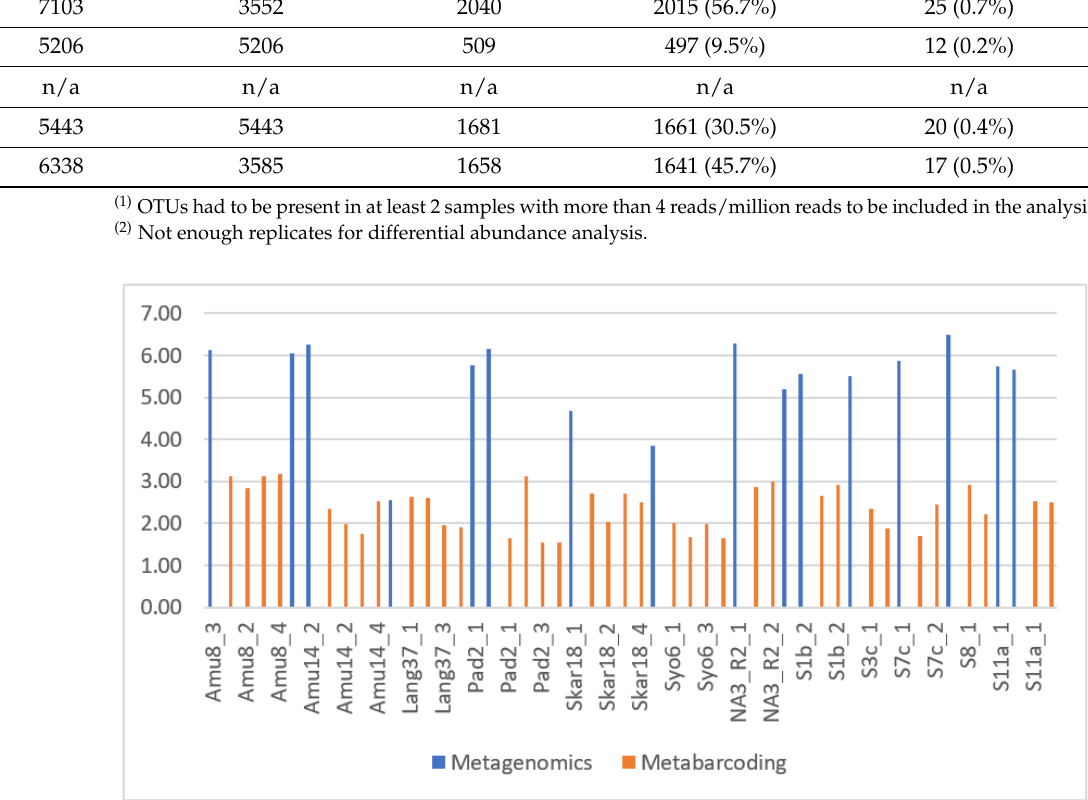
Table 1. Differential abundance of taxonomic tags (species taxonomic level) in metagenomic and metabarcoding studies of terrestrial soil samples from polar regions. Sequences were classified with the Kraken 2 software and differential abundance analyses performed using edgeR and standard settings. The percentage of filtered taxonomic tags over ‐ or underrepresented in metagenomes is given in brackets. Site